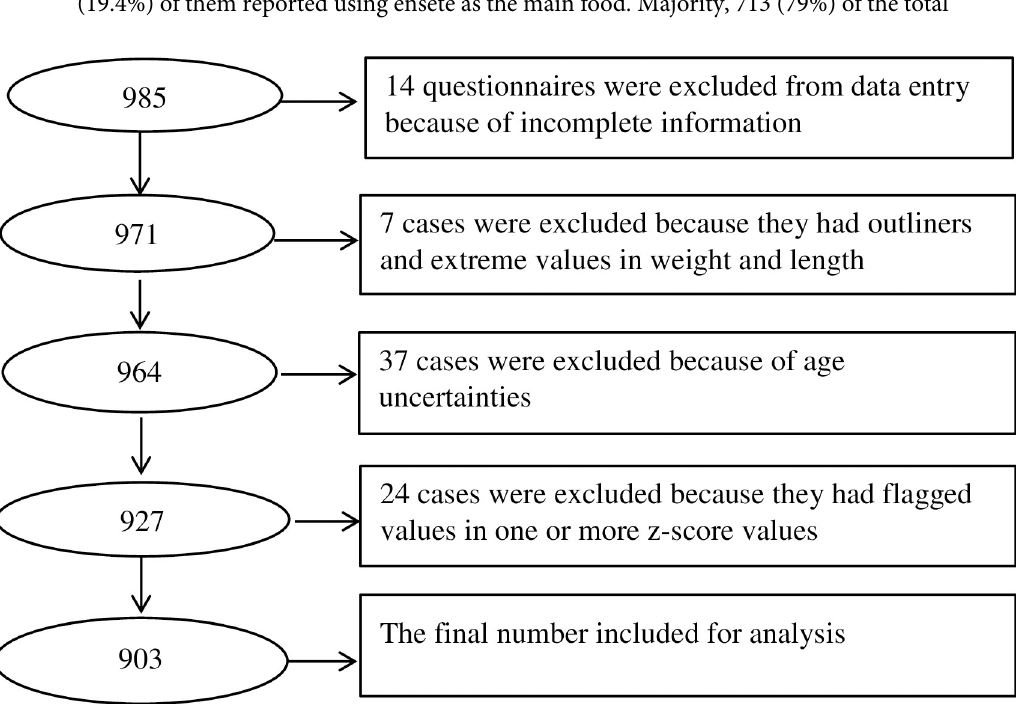
Fig 1. Flow chart showing a stepwise exclusion of the study subjects during data cleaning and